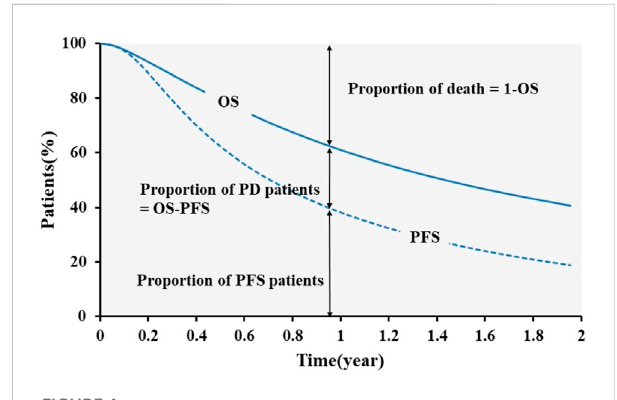
FIGURE 1 Model structure of the partitioned survival